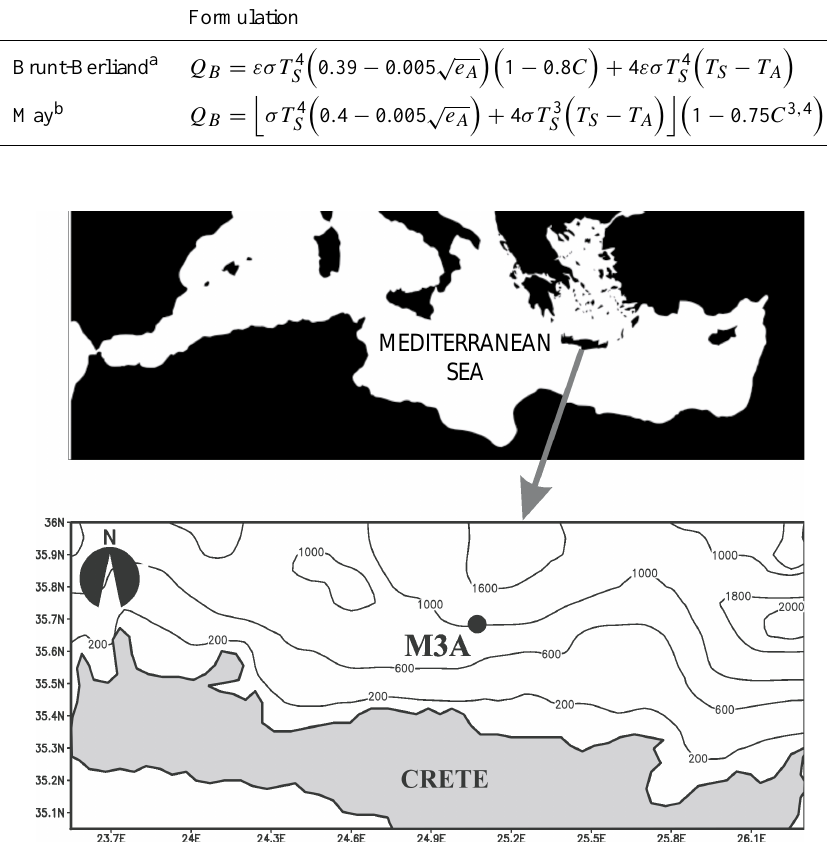
Fig. 2. The location of the M3A buoy